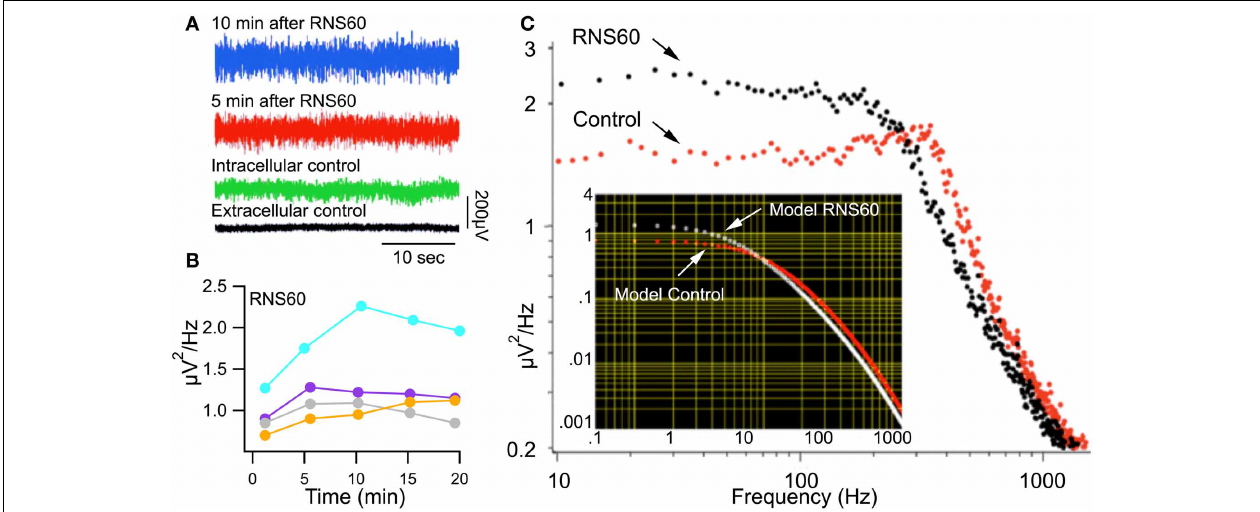
FIGURE 3 | Synaptic noise recorded in Control ASW and RNS60 ASW. (A) Recordings showing synaptic noise across the postsynaptic membrane superfused with control ASW (green) and the increase in noise amplitude 5min (red) and 10min (blue) after superfusion with RNS60 ASW as well as the background extracellular noise recorded directly from the bath (black). (B) Plot of change in noise amplitude as a function of time after